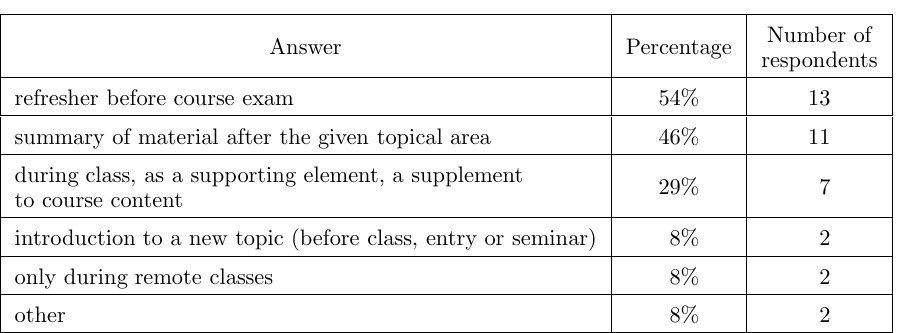
Table 2. Distribution of answers to the multiple-choice question “To which goal would you like to use multimedia materials (videos, interactive presentations, animations)?”